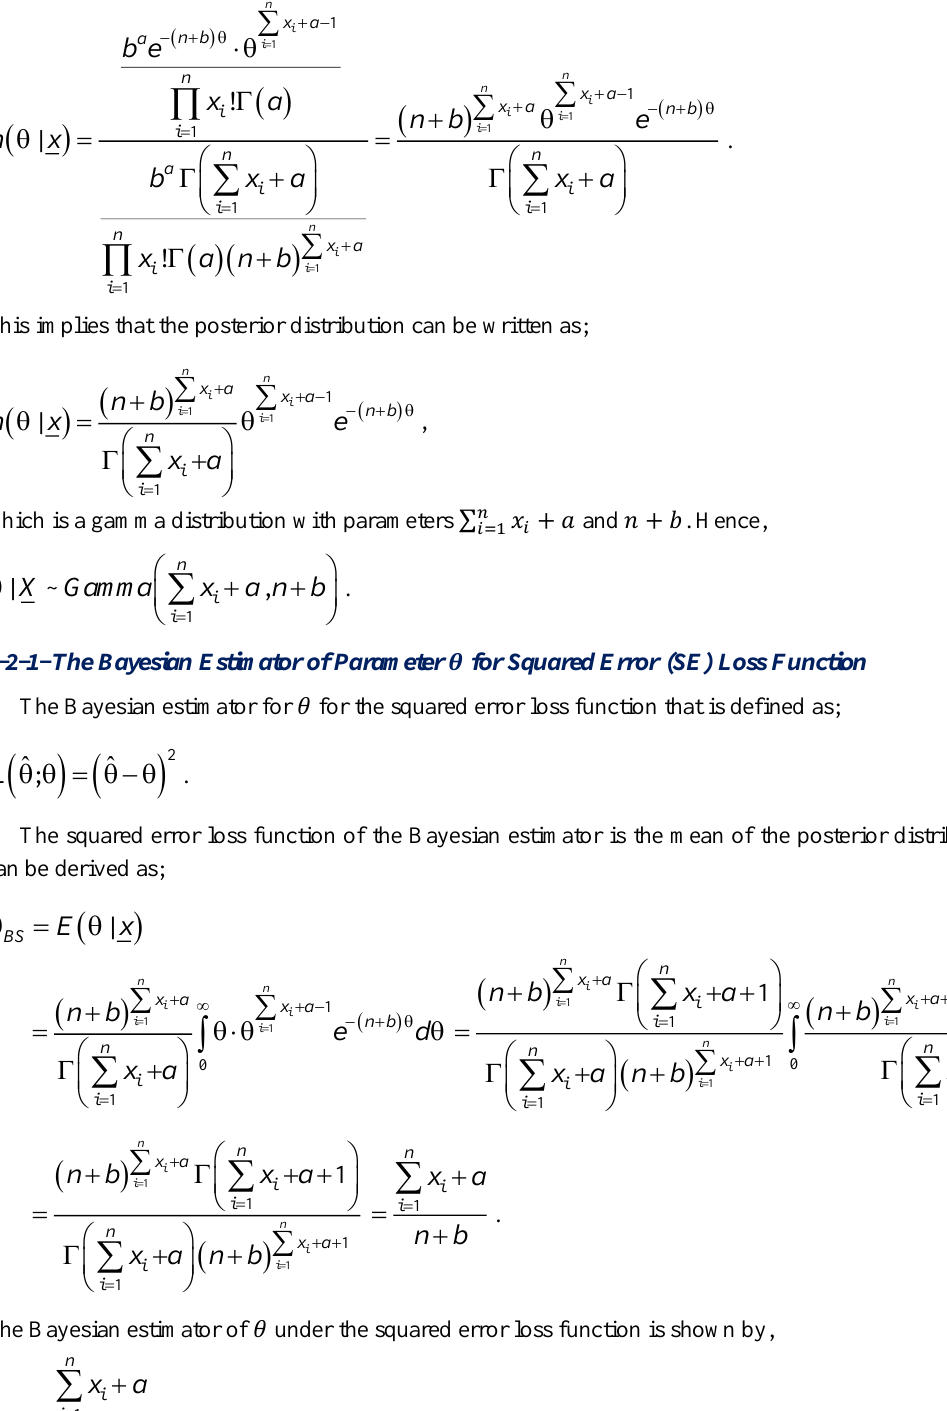
2-2-2- The Bayesian Estimator of Parameter 𝜽 for Quadratic Loss (QL) Function The quadratic loss function which is a non-negative symmetric and continuous loss function of parameter 𝜃 and estimate of 𝜃̂ for the Bayesian estimator is defined as